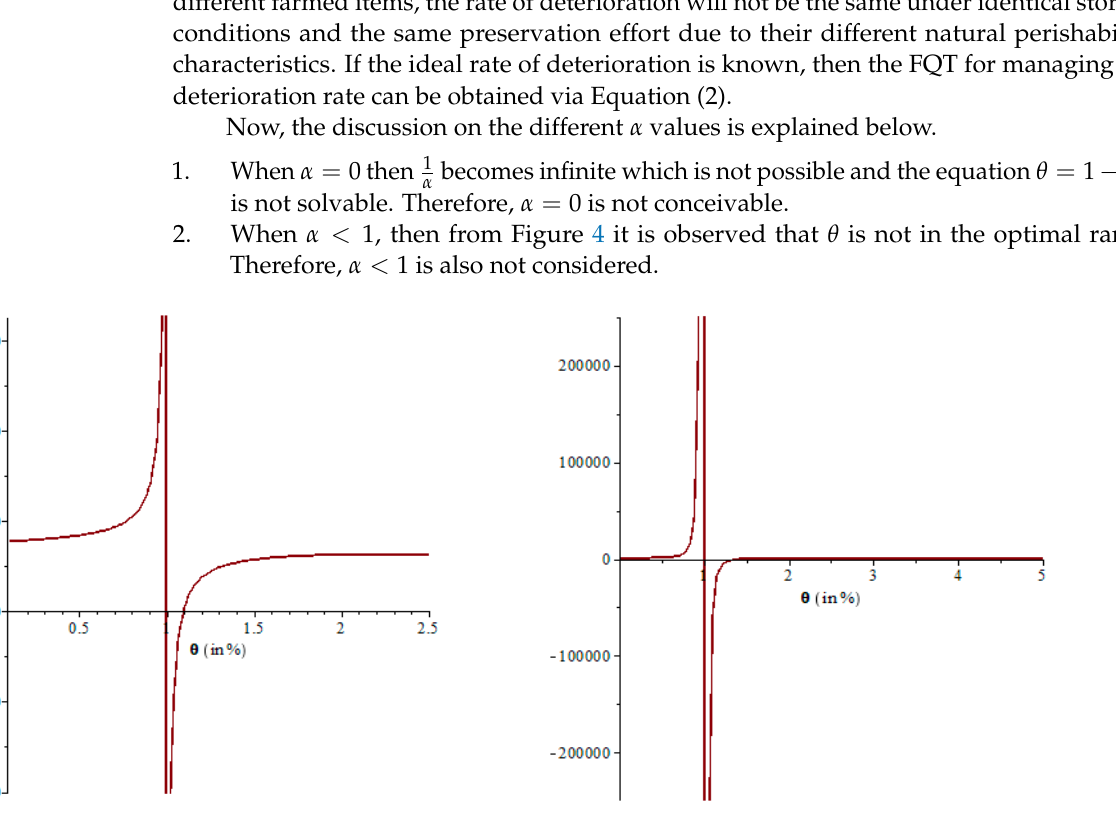
Figure 4. Optimal range of θ when 1 α< for Case (I) and Case (II).